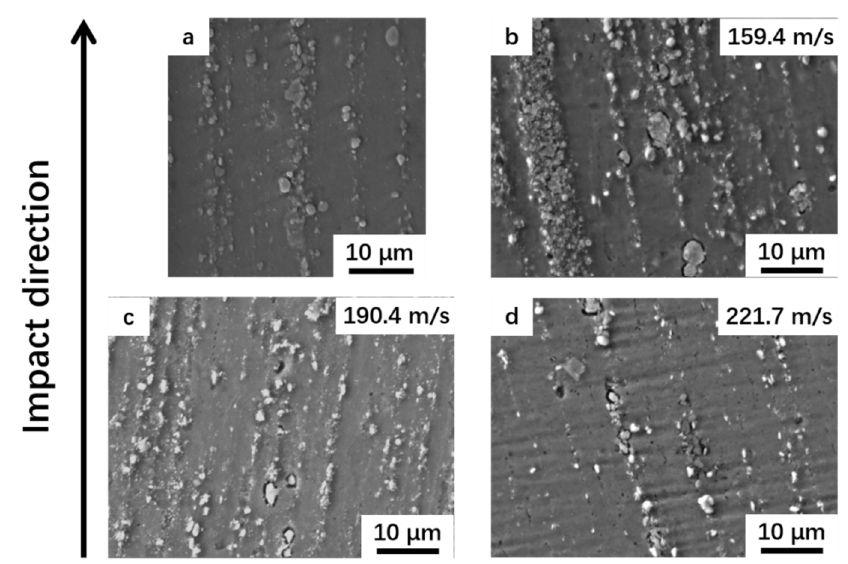
Figure 10. SEM micrographs of specimens ( a ) before impact; and after impact at different velocities: ( b ) v = 159.4 m/s; ( c ) v = 190.4 m/s and ( d ) v = 221.7 m/s.